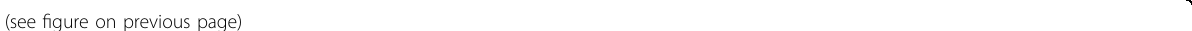
Fig. 1 Apigenin sensitizes NSCLC cell lines and primary patient-derived lung cancer cells to TRAIL-induced apoptosis. a Cell viability was evaluated using MTT assays in A549 and Calu-1 human NSCLC cell lines and normal nontransformed primary human lung fi broblasts (LF) pretreated with 10, 25, or 50 μ M apigenin or DMSO (diluent control, noted as 0) or for 18 h followed by treatment with TRAIL (25, 50, or 100 ng/ml) for additional 6 h. Cell viability was also evaluated in A549 cells pretreated with 10, 25, or 50 μ M genistein or diluent for 18 h followed by TRAIL treatment for additional 6 h. b Cell viability was evaluated in PHLECs isolated from paired tumor tissue biopsies (PHLEC-ACCs) and nontumor tissue biopsies (nontumor PHLECs) from three subjects (P1 – P3) and pretreated with 10, 25, or 50 μ M apigenin or diluent for 18 h followed by 25, 50, or 100 ng/ml TRAIL for an additional 6 h. c – f The percentage of cells stained with AnnexinV/7-AAD ( c ) or active caspase-3 ( e ), which are markers of apoptosis, was evaluated in PHLEC-ACCs isolated from P1 to P3. Cells were pretreated with 50 μ M apigenin or DMSO (indicated as -) for 18 h followed by 100 ng/ml TRAIL for 6 h, and then quanti fi cation was performed with fl ow cytometry. A representative fl ow cytometry plot of cells isolated from P1 stained with AnnexinV/7-AAD ( d ) or active caspase-3 and 7-AAD ( f ). All data are presented as the mean ± SEM ( n = 3; ** P < 0.01, and *** P < 0.001; and analyses were performed with two-way